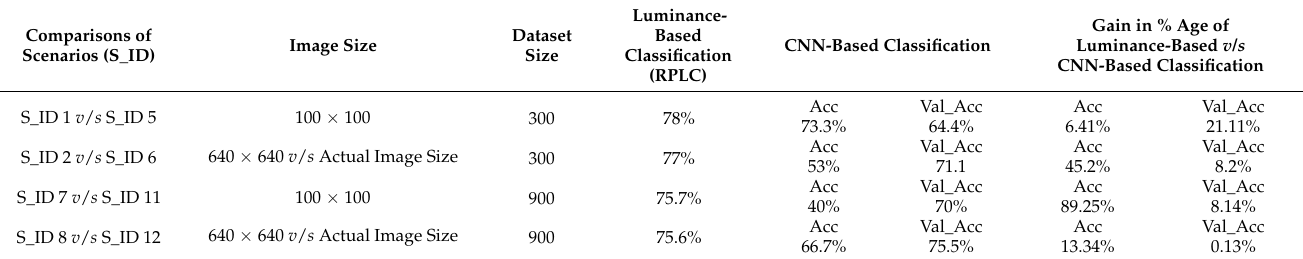
Table 6. Gain analysis of RPLC algorithm over CNN based classification.